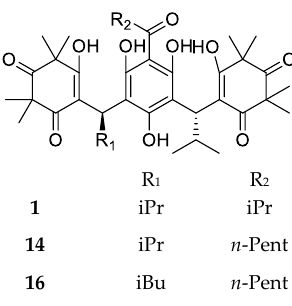
Figure 3. Structures of trimeric compounds. Compound 1 is reported as ( R , R )-stereoisomer.